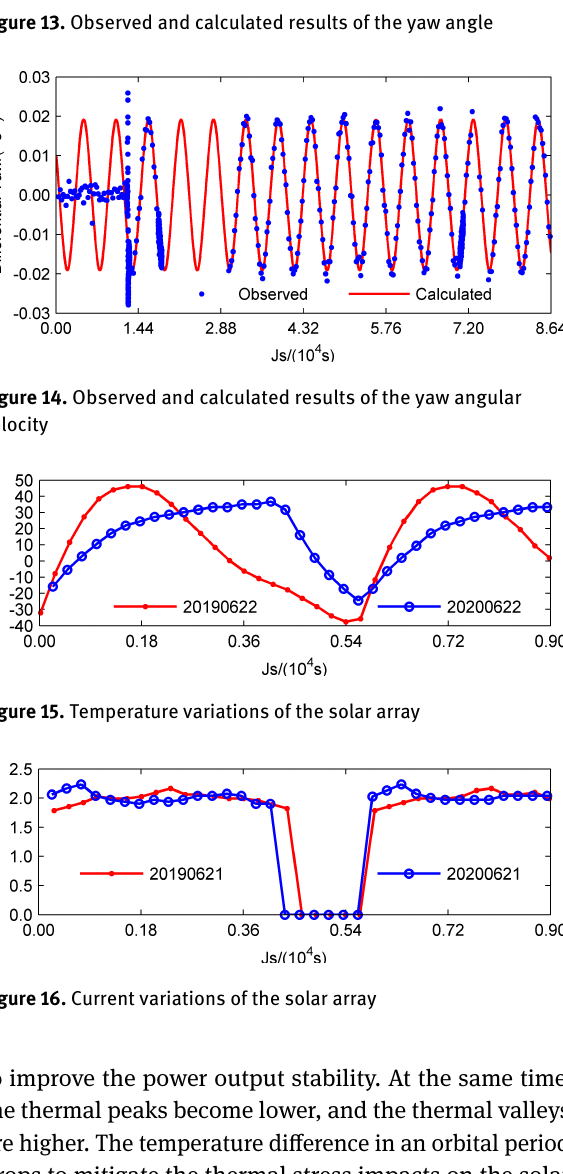
to improve the power output stability. At the same time, the thermal peaks become lower, and the thermal valleys are higher. The temperature difference in an orbital period drops to mitigate the thermal stress impacts on the